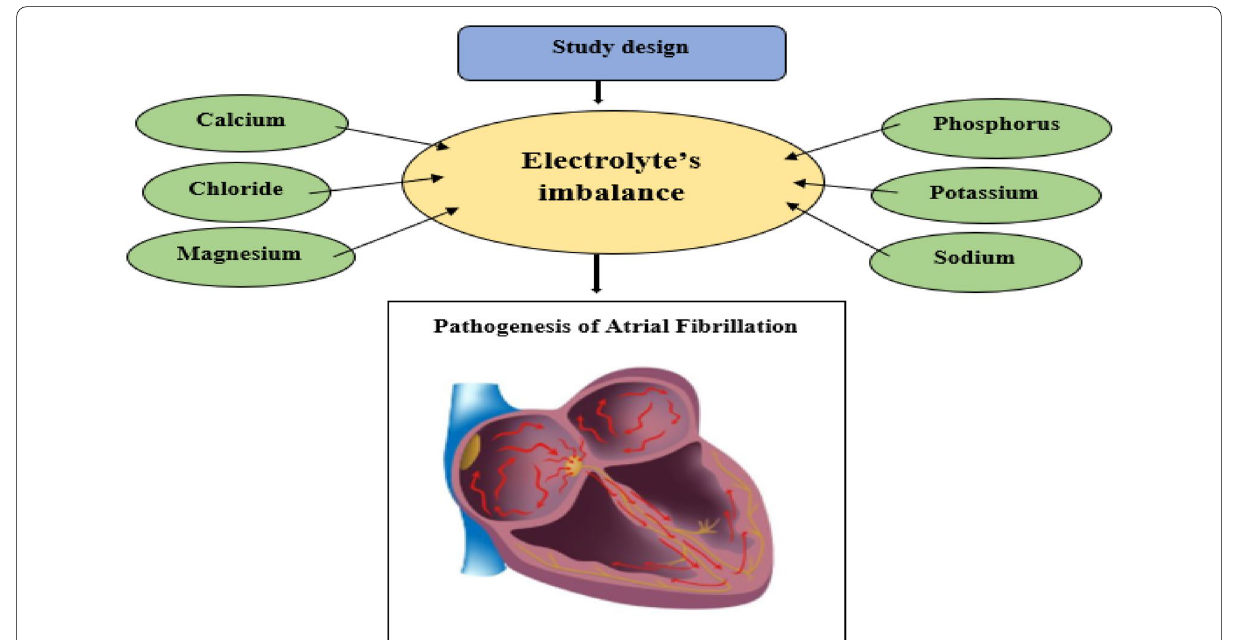
Fig. 1 Overall plan of the review article Source: Designed by the author with the help of review